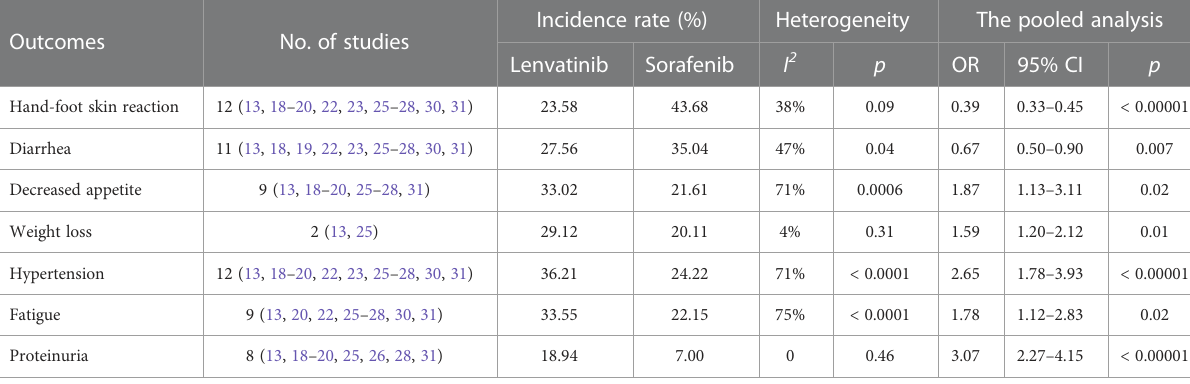
TABLE 2 Comparison of the incidence of common AEs between the two groups. Incidence rate (%) Heterogeneity The pooled Outcomes No. of studies